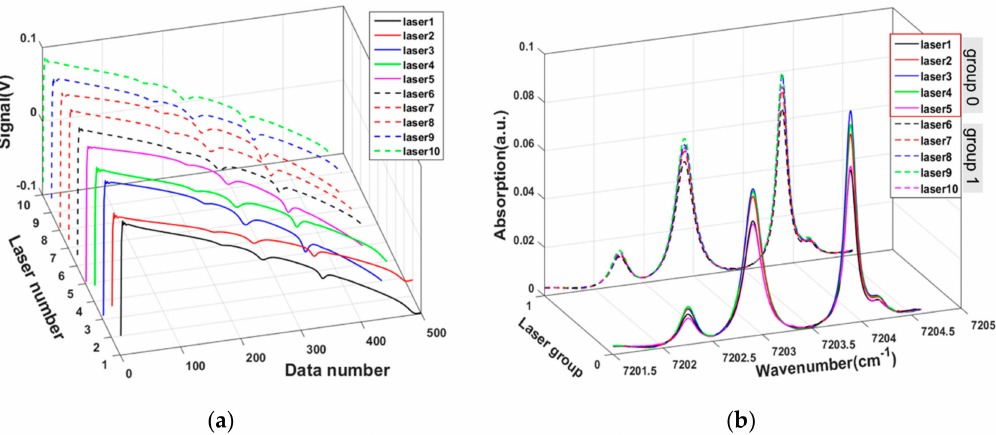
Figure 4. Results of mean transmission signals and mean absorption spectra of 10 laser beams: ( a ) 10 mean transmitted signals using 201 cycles and ( b ) 10 mean absorption spectra using 201 cycles.